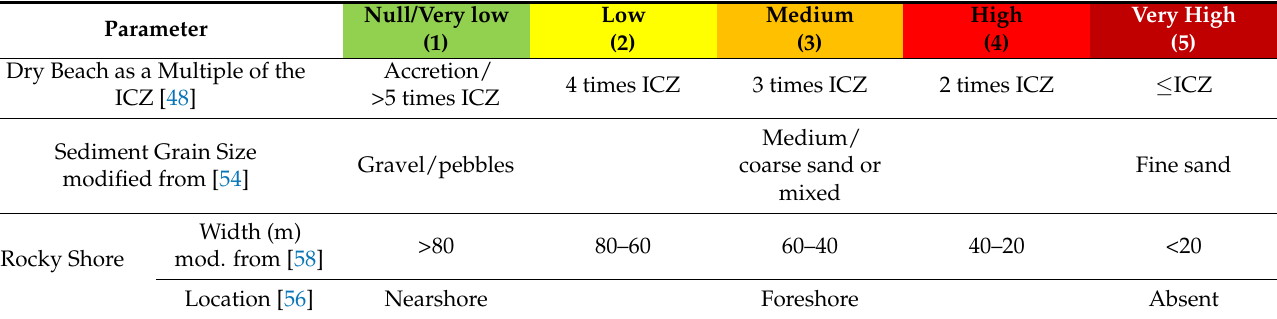
Table 3. “Beach face” parameter rating.